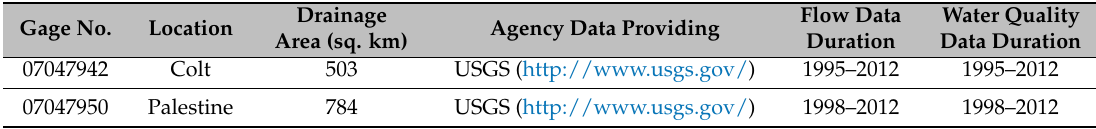
Table 4. Measured data sites in L’Anguille River Watershed